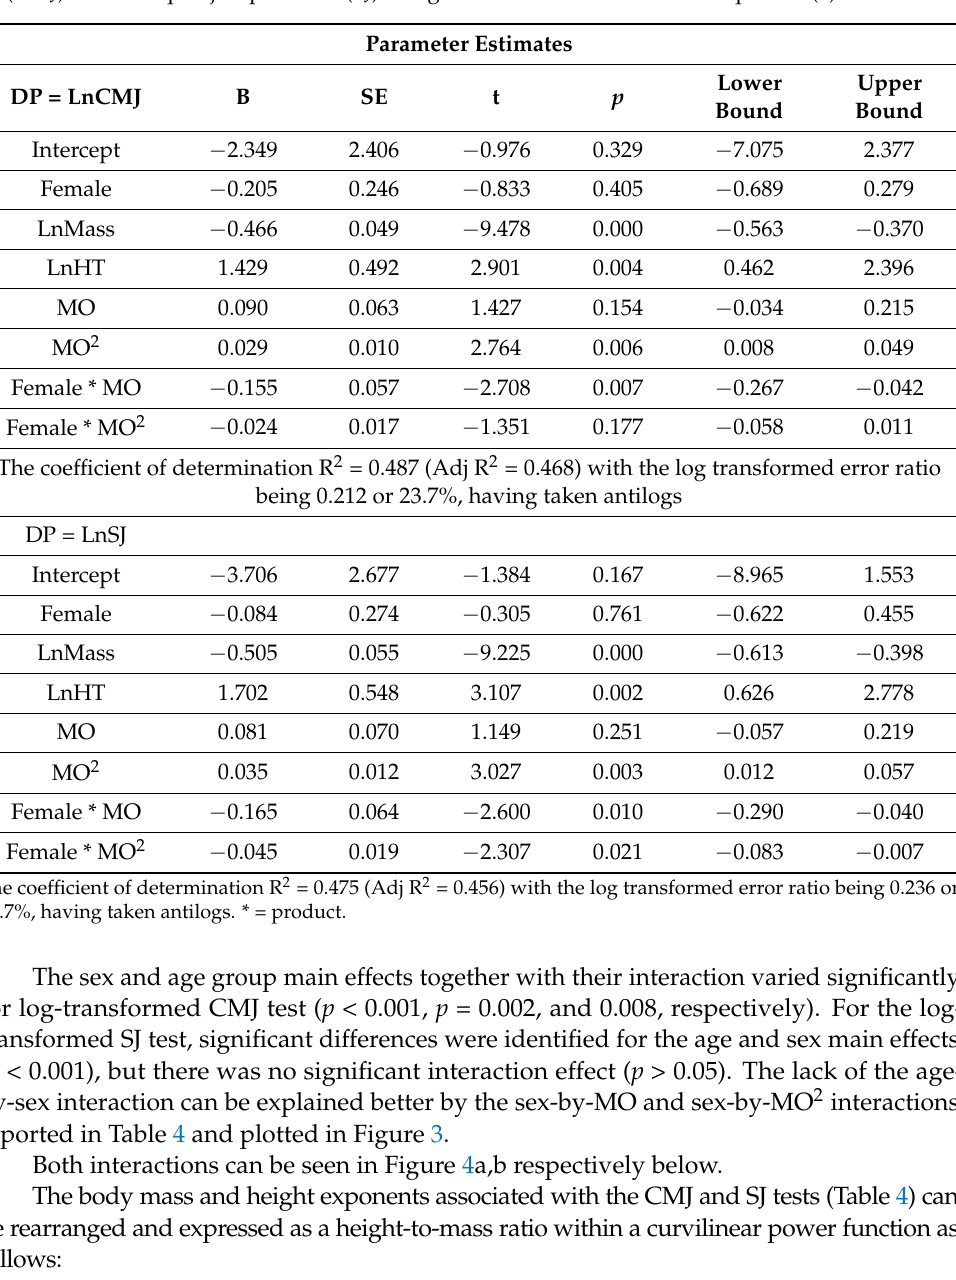
Table 4. The fitted ANCOVA parameters predicting log-transformed countermovement jump Ln(CMJ) and the squat jump tests Ln(SJ) using the covariates described in Equation